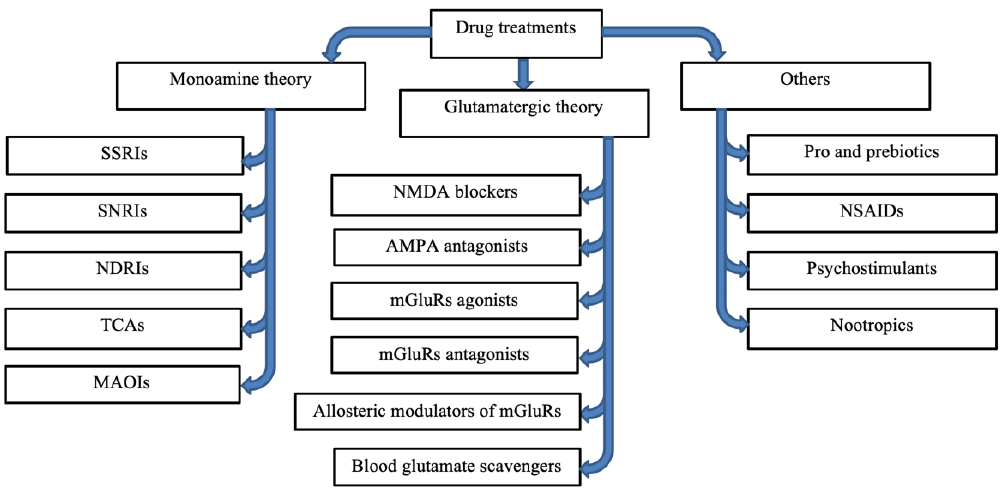
Figure 5. Approaches to drug treatment of PSD, categorized by their utilization of monoamine theory, the glutamatergic theory, or others.